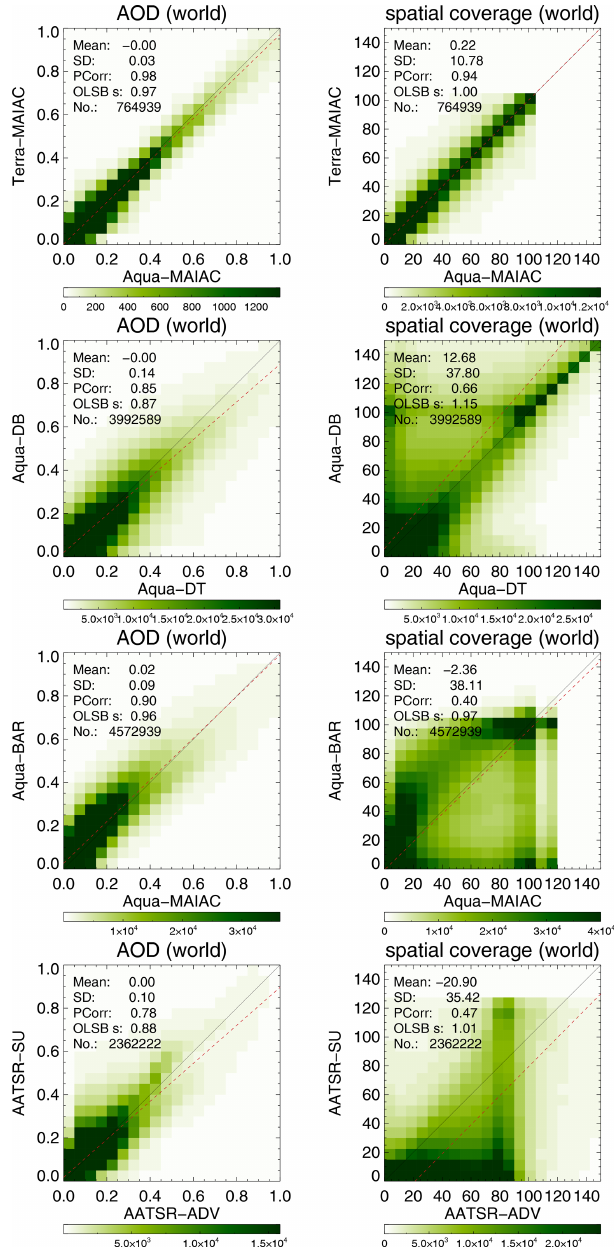
Figure 17. Scatterplot of AOD and spatial coverage from super- observations for selected satellite products. Products were collo- cated pair-wise within 1h.